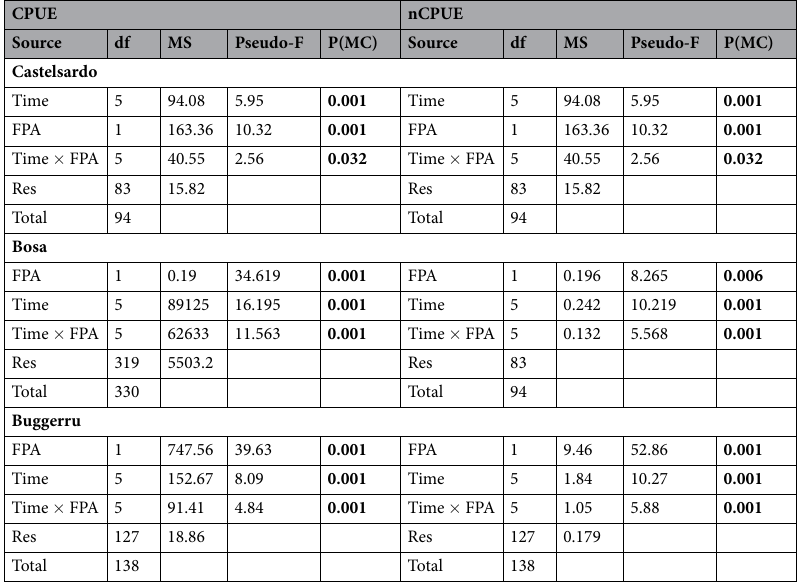
Table 2. Output from the PERMANOVA analysis (main test). Significant Monte Carlo procedure p-values [P(MC)] are reported in